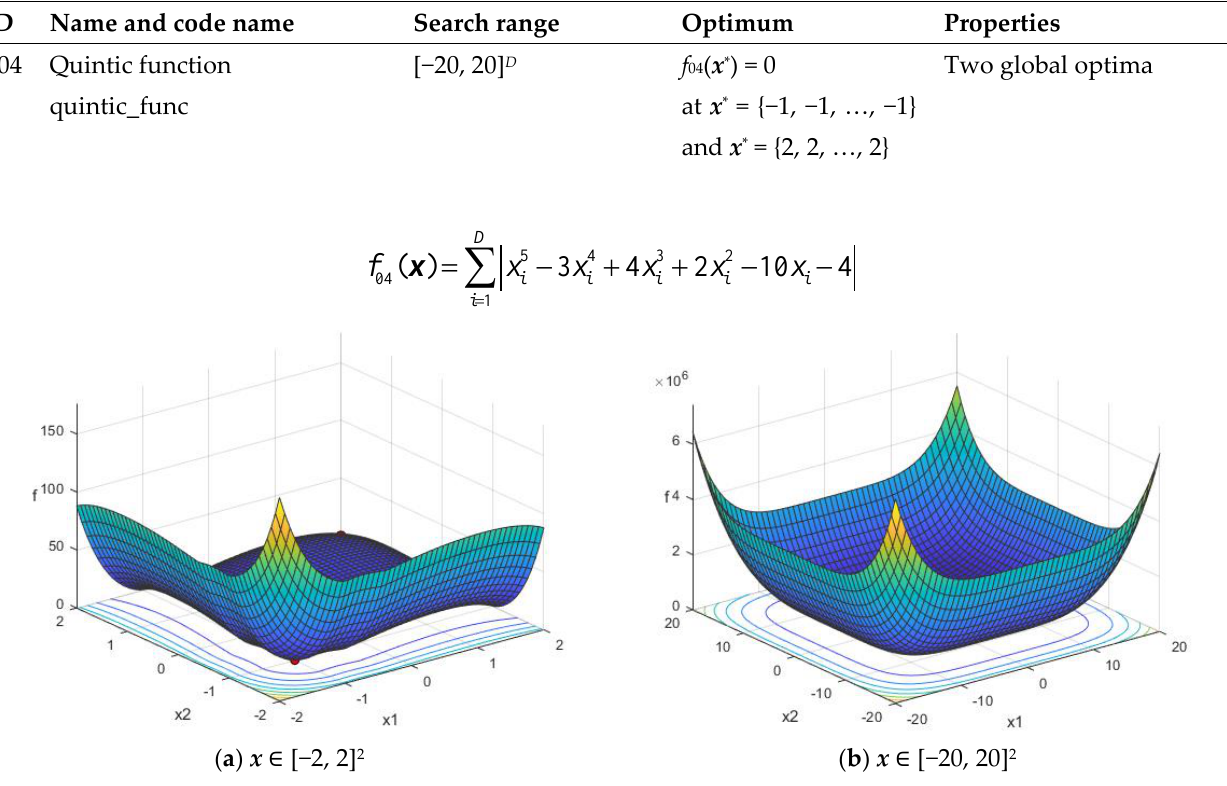
Figure A4. Quintic function in two dimensions.